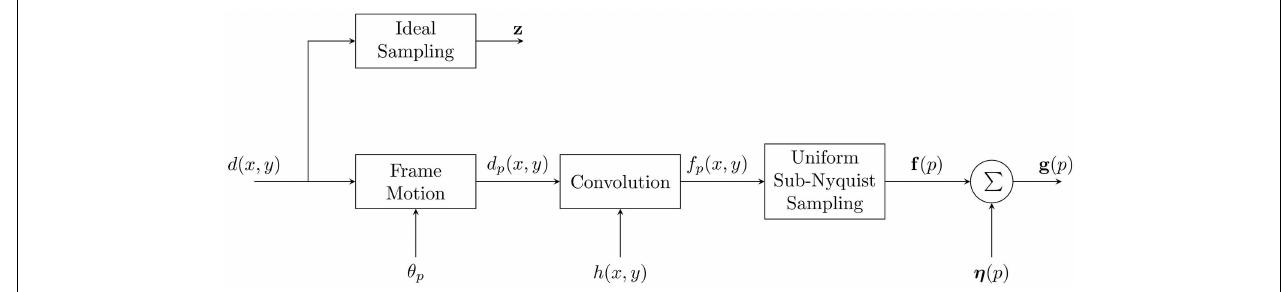
FIGURE 1 | Forward observation model relating the desired continuous image, d ( x , y ) to the observed LR frames, g ( p ) .